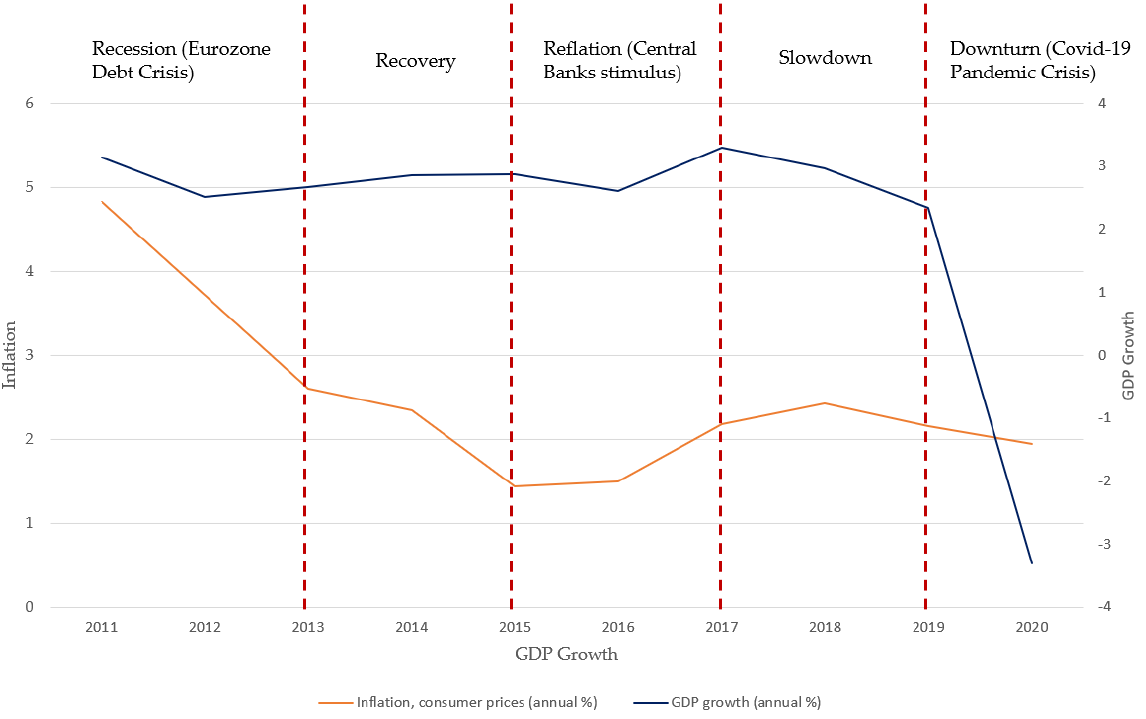
Figure 2. Business cycles in 2011–2020. Source: authors’ elaboration based on World Bank Data. Notes: The inflation and GDP growth world data are year-on-year. The red dotted lines delimit the end of the business